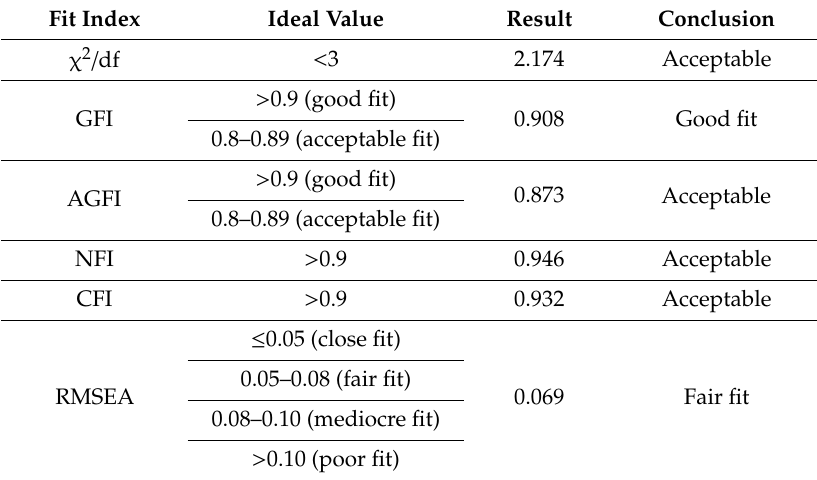
Table 3. Results of the fit indicators of the evaluation